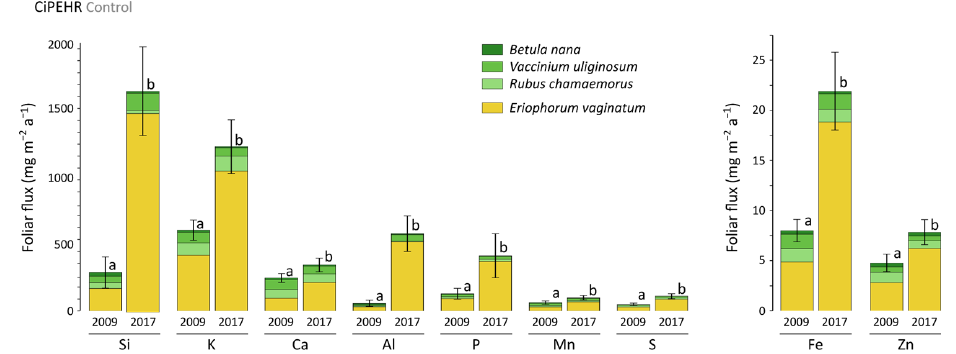
Figure 5. Evolution over time of the cumulative annual foliar fluxes (mgm − 2 a − 1 ) of mineral elements for the considered species across the control area of the experimental warming site (CiPEHR). Vegetation is sorted by plant functional types: deciduous shrubs and forbs (green) and sedges (yellow). Letters correspond to a mixed-effects model analysis and compare the total foliar elemental stocks between 2009 and 2017. Error bars represent standard deviations.